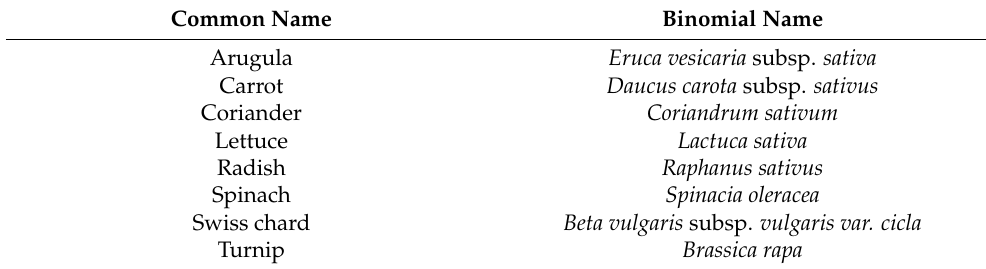
Table 1. Vegetable crops selected for the phenophase image dataset